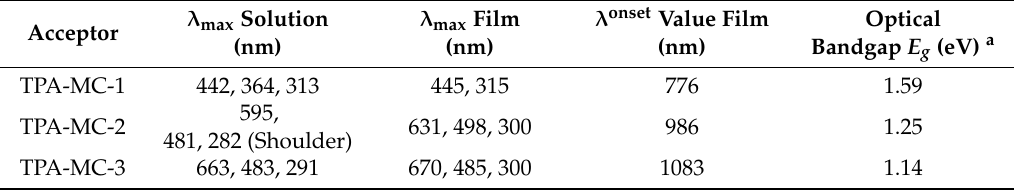
Figure 2. UV–Vis spectra of TPA-MC-1, TPA-MC-2, and TPA-MC-3 in solution (solid lined) and thin film (dashed lines). Table 1. Optical properties of TPA-MC-1, TPA-MC-2 and TPA-MC-3.